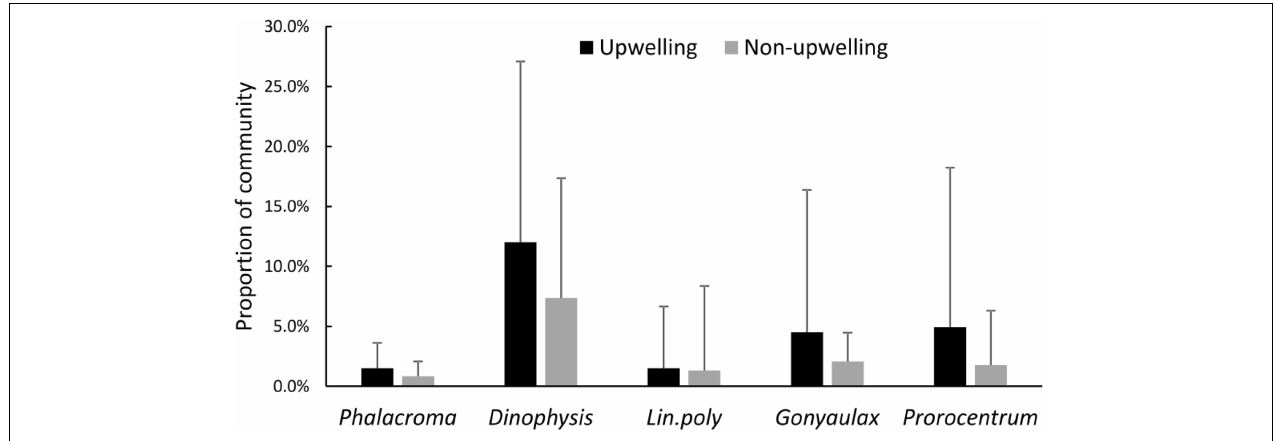
FIGURE 4 | Potentially HAB dinoflagellate genera relative abundance, means for upwelling and non-upwelling periods; bars: standard error.